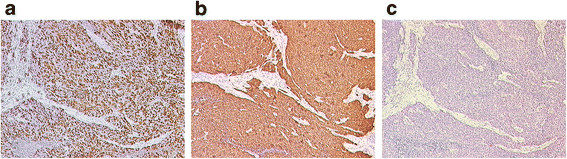
Immunohistochemical staining ofCyclin A1(a),p16(b) andp53(c) in HNSCC. Tumor of a 77 year old man; primary site: tonsil; HPV16 positive; Cyclin A1 overexpression (category 8); P16 overexpression (category 9); P53 negative (category 1); original magnification: x50